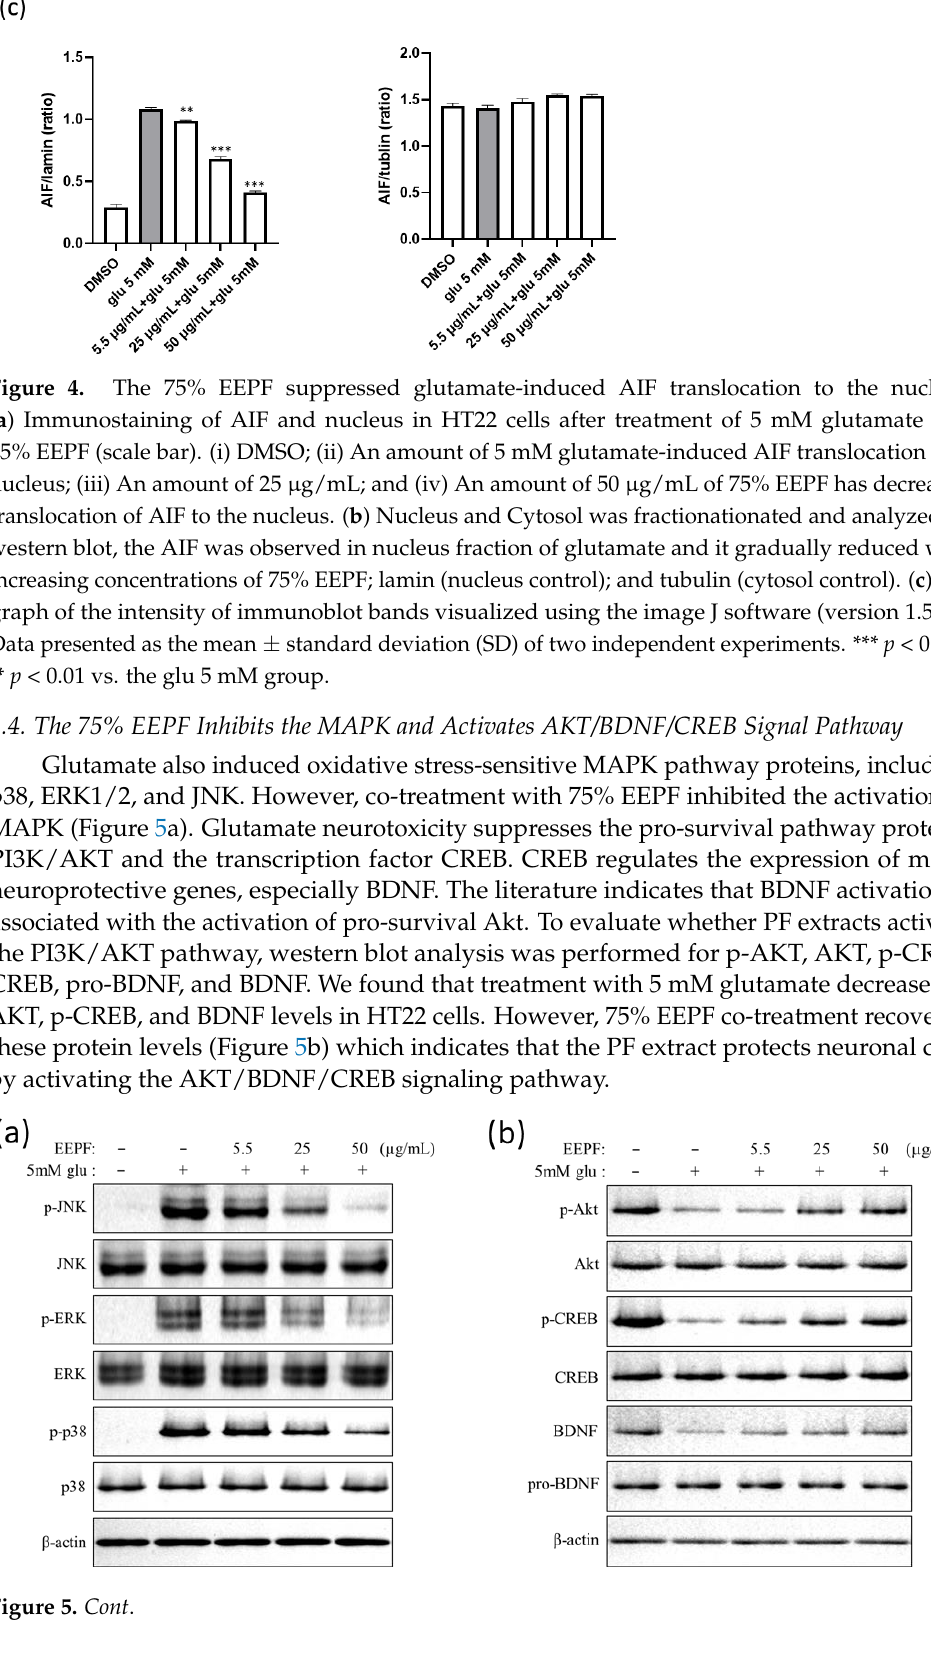
Figure 5. The 75% EEPF regulates MAPK activation and PI3K/AKT/CREB. ( a ) Protein expression levels of p-JNK, JNK, p-ERK, ERK, p-p38, and p38. ( b ) Protein expression levels of p-AKT, AKT, p- CREB, CREB, BDNF, and pro-BDNF. The glutamate and 75% EEPF was treated for 8 hrs and western blot was performed. ( a ) The 75% EEPF co-treatment inhibited p-JNK, p-ERK, and p-p38 protein level. ( b ) The 75% EEPF co-treatment rescued the p-AKT, p-CREB, and pCREB proteins levels. ( c ) and ( d ) Bar graphs of the intensity of immunoblot bands visualized using the image J software. Data presented as the mean ± standard deviation (SD) of two independent experiments. *** p < 0.001, ** p < 0.01 vs. the glu 5 mM group. 2.5. The 75% EEPF Reverses Glutamate-Mediated Altered Ratio of Bcl-2 and Bax Proteins The Bcl-2 protein family regulates pro- and anti-apoptotic factors and is associated with glutamate-induced cell death. Glutamate changes the anti-apoptotic Bcl-2 and pro- apoptotic Bax ratio, which selectively regulates both pro-survival and cell death path- ways. Therefore, we analyzed these two protein levels after 75% EEPF treatment in HT22 cells by immunoblot. The results demonstrated that glutamate increased Bax and de- creased Bcl-2 levels. However, polyscias treatment reduced Bax and increased Bcl-2 levels, which prevented the activation of apoptotic cell death mediated by glutamate (Figure 6a).